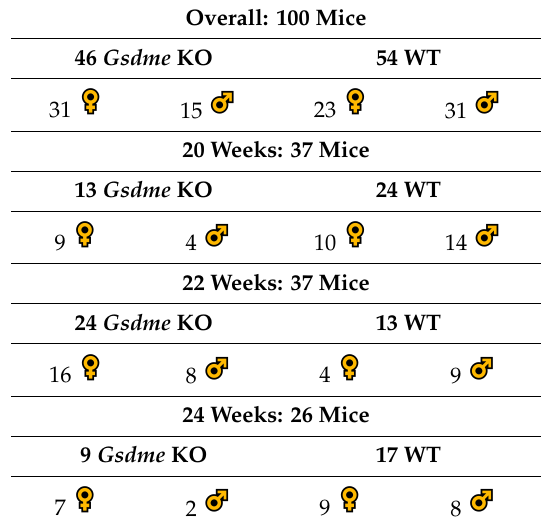
Table 2. The number of mice per timepoint, with genotype and sex, used in the AOM-induced cancer mouse model experiment.